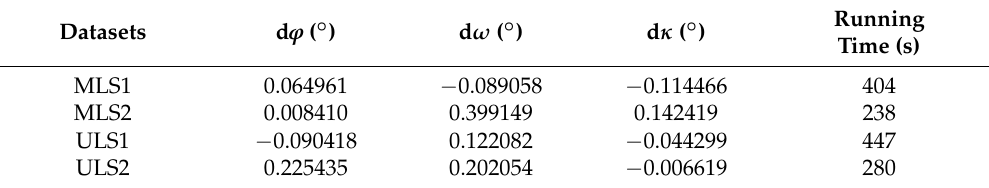
Table 2. The estimated boresight angle correction parameters and running time of calibration.